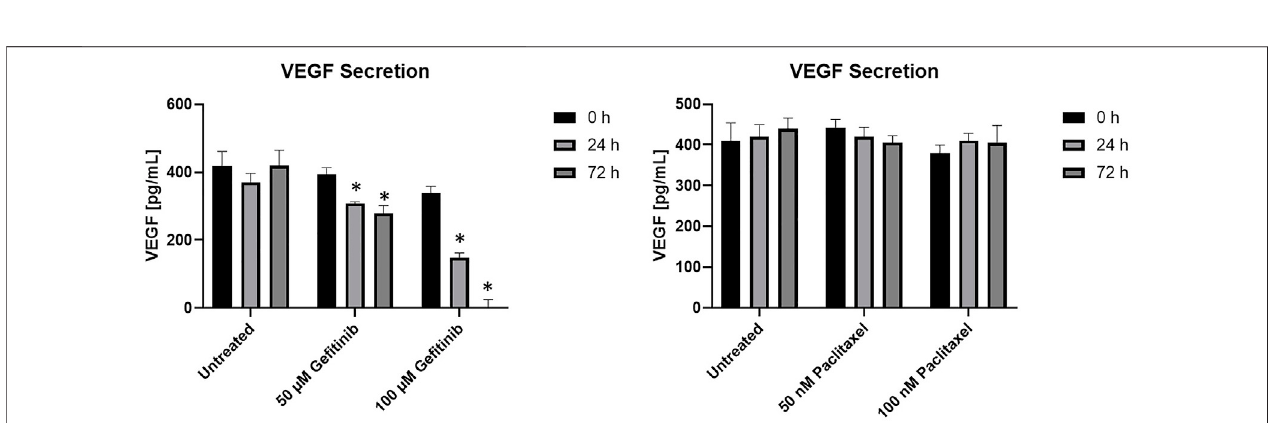
FIGURE 7 | ELISA of tri-cultures with different ge fi tinib (A) and paclitaxel concentrations (B) at different time points with the pro-angiogenic cytokine VEGF. VEGF concentrationincell-freemediumwassubtractedfromallmeasuredvalues.Errorbarsshowstandarddeviation.Statisticalsigni fi canceindicatedby*showssigni fi cance ( p < 0.05) between mean